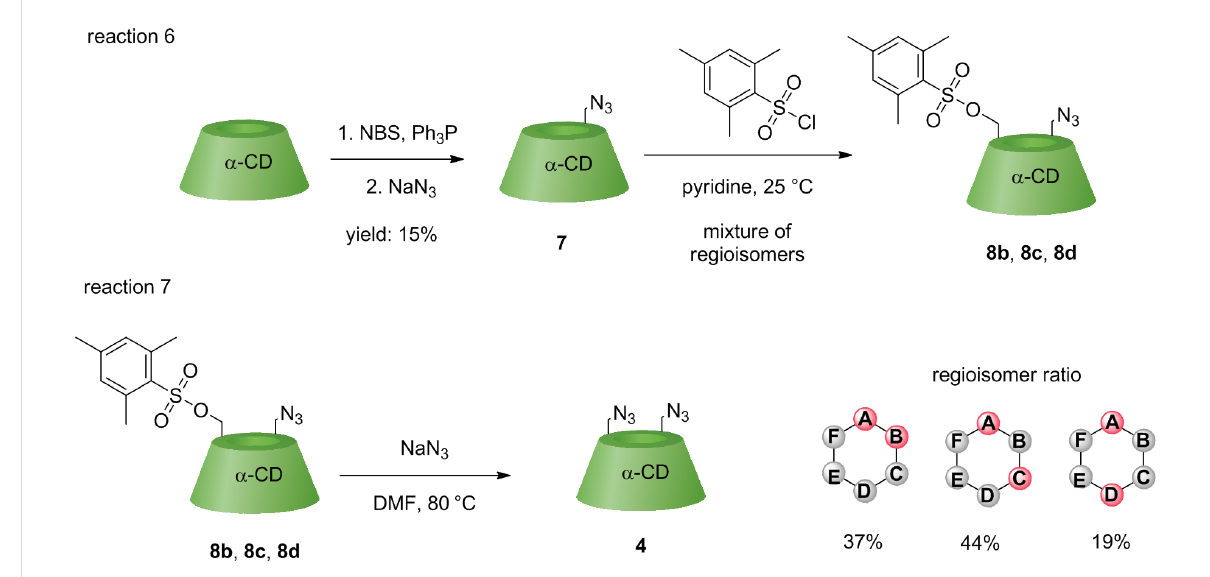
Synthesis and large-scale separation